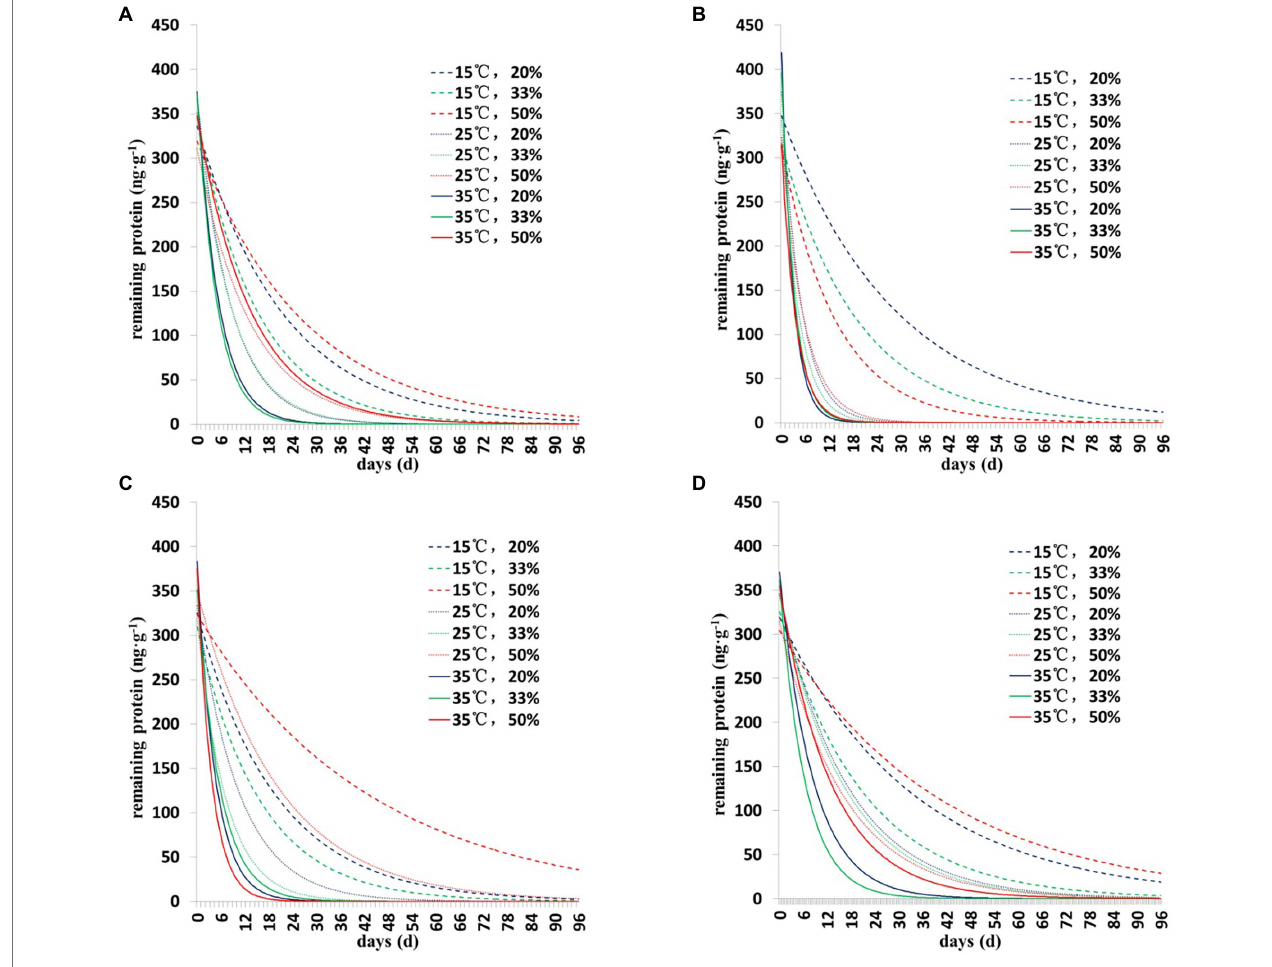
FIGURE 1 | The degradation dynamics of Cry1Ah protein in the soil in four soil types under different environmental conditions. The data were calculated following degradation model Y = ae − b * X . (A) Gongzhuling, (B) Jinan, (C) Beijing, and (D) Zhengzhou; temperature (15 ° C, 25 ° C, and 35 ° C), water content (20, 33, and